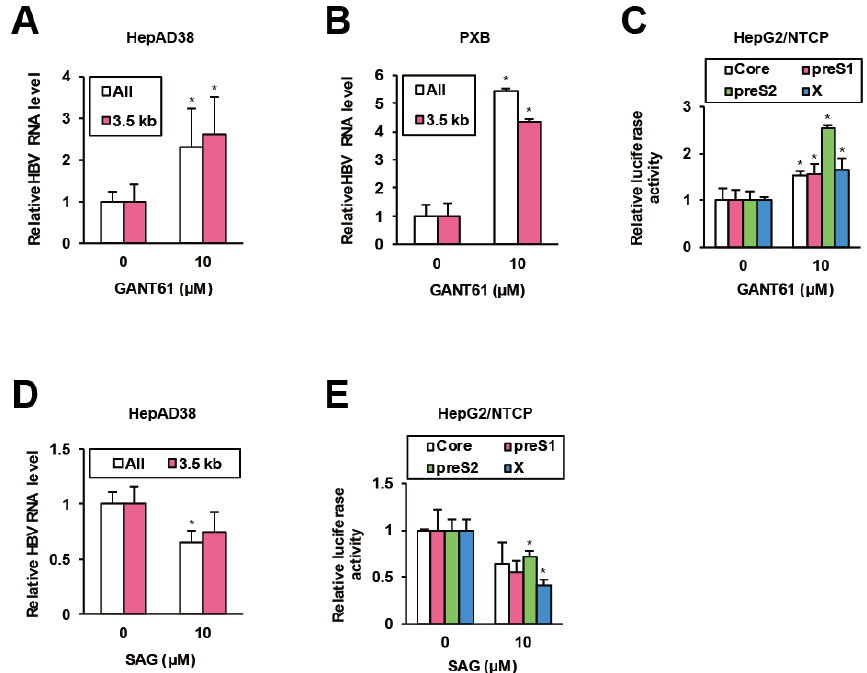
Figure 4. HH signaling suppresses HBV. ( A ) The e ff ects of GANT61 on HBV RNA levels in HepAD38 cells. After preculture without Tet for 7 days, the cells were treated with GANT61 at 10 µ M for 6 days in the presence of Tet, and the relative RNA levels were measured by qRT-PCR. ( B ) The e ff ects of GANT61 on HBV RNA levels in PXB cells. Twenty four hours after the infection with HBV, PXB cells were treated with GANT61 at 10 µ M for 4 days. The relative RNA levels were measured by qRT-PCR. ( C ) The e ff ects of GANT61 on activities of viral promoters. Twenty four hours after the transfection of the reporter plasmids carrying viral promoters, HepG2 / NTCP cells were treated with GANT61 at 10 µ M for 24 h, and the relative luciferase activities were measured. ( D ) The e ff ects of SAG on HBV RNA levels in HepAD38 cells. As in ( A ), the cells were treated with SAG at 10 µ M and the relative RNA levels were measured by qRT-PCR. ( E ) The e ff ects of SAG on activities of viral promoters. As in ( C ), the cells were treated with SAG at 10 µ M, and the relative luciferase activities were measured. Statistical significances with p < 0.05 to controls were indicated by